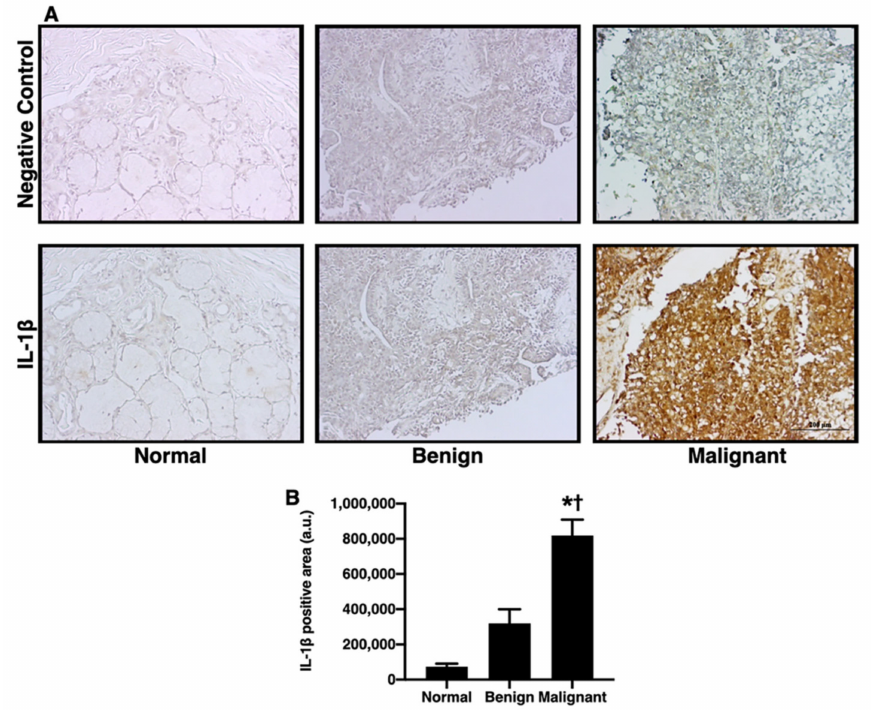
Figure 3. The IL-1 β expression in oral salivary gland tumors. ( A ) The example images of IL-1 β positive areas as indicated by IHC staining in normal, benign, and malignant groups (left to right panel, respectively) (bar= 200 µ m). ( B ) Malignant group, but not benign group, increased IL-1 β positive area. * p < 0.05 vs. normal, † p < 0.05 vs.